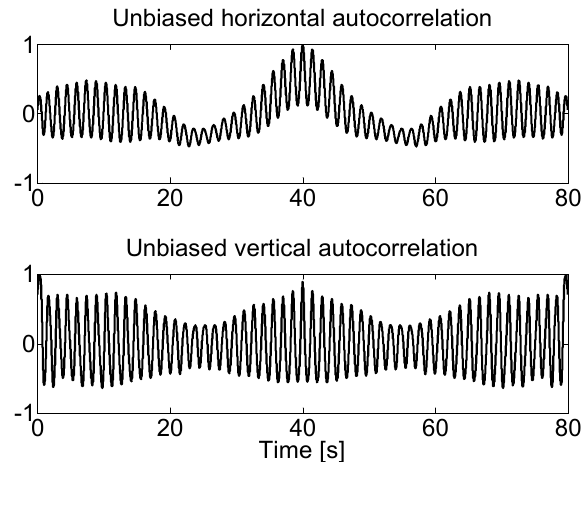
Figure 4. Horizontal and vertical unbiased autocorrelation plots of abnormal